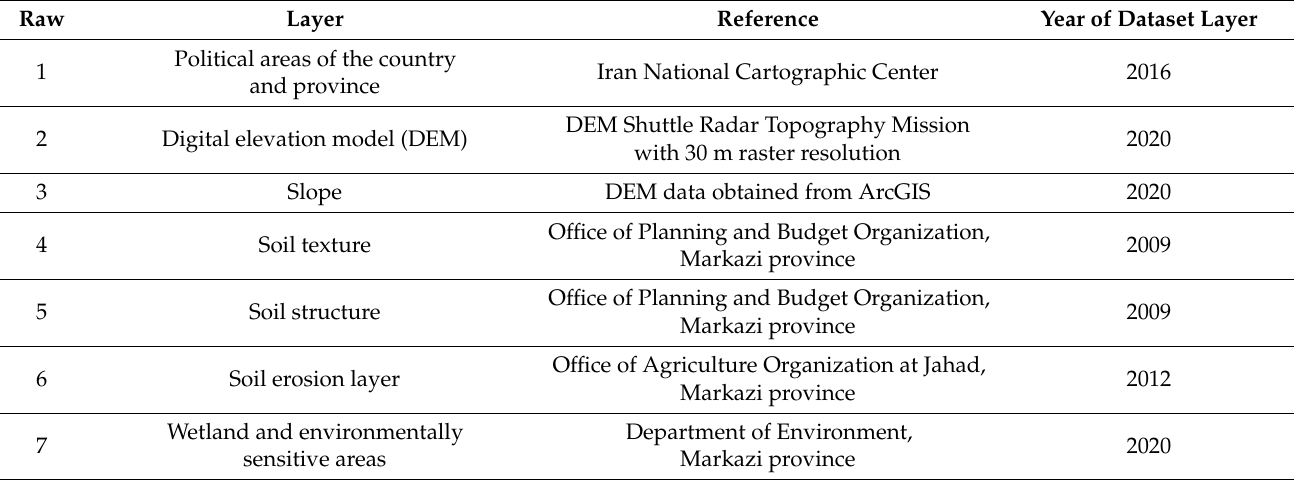
Table 1. Raw data in the study.